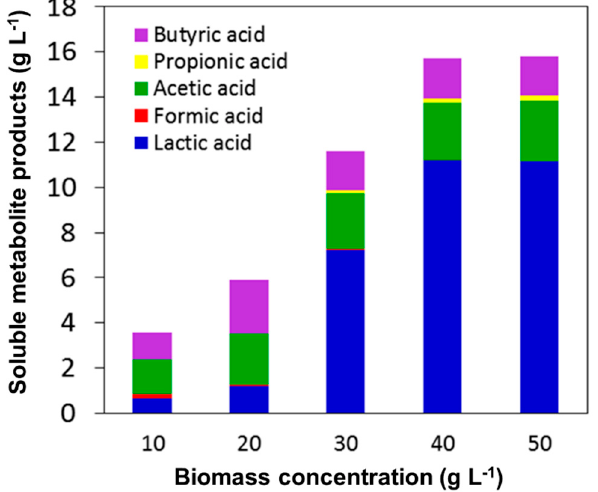
Figure 2. Soluble metabolite products in the acidic effluent after hydrogen production from the Chlorella sp. biomass by SSF.